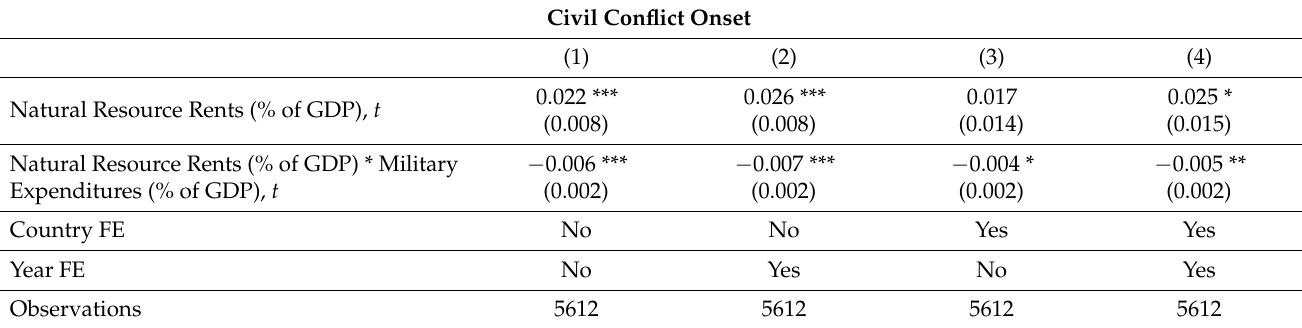
Table 3. Robustness: Alternative Functional Form No Logging of RHS